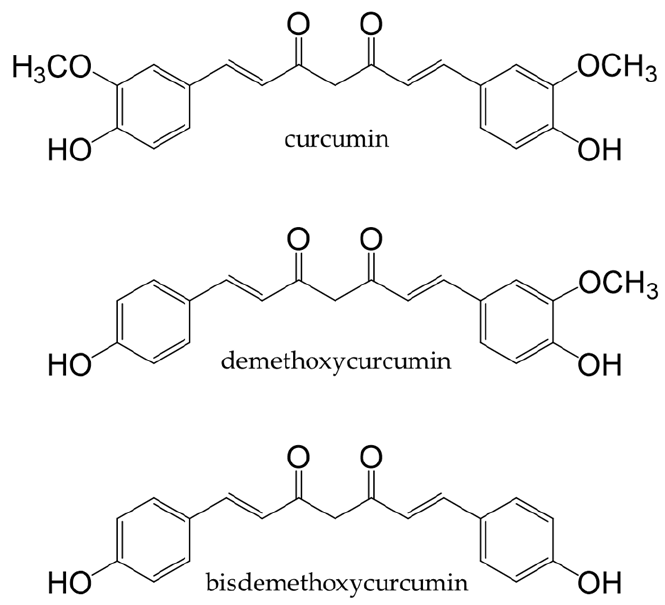
Figure 15. Chemical structures of curcuminoids.